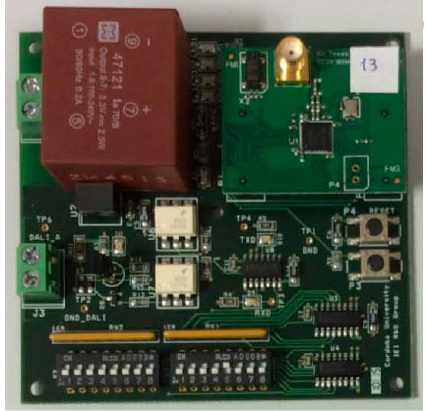
Figure 9. UCODALI version 2 board.